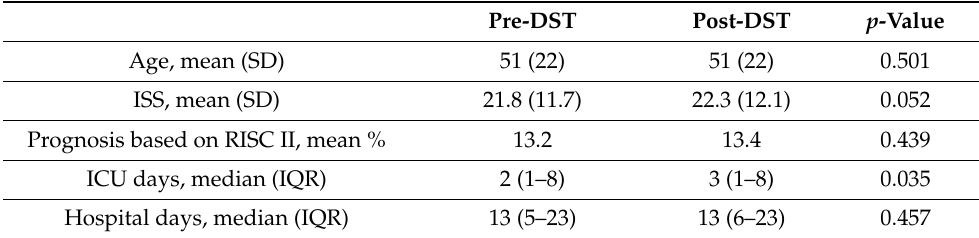
Table 3. Impact of DST in major trauma—spring and